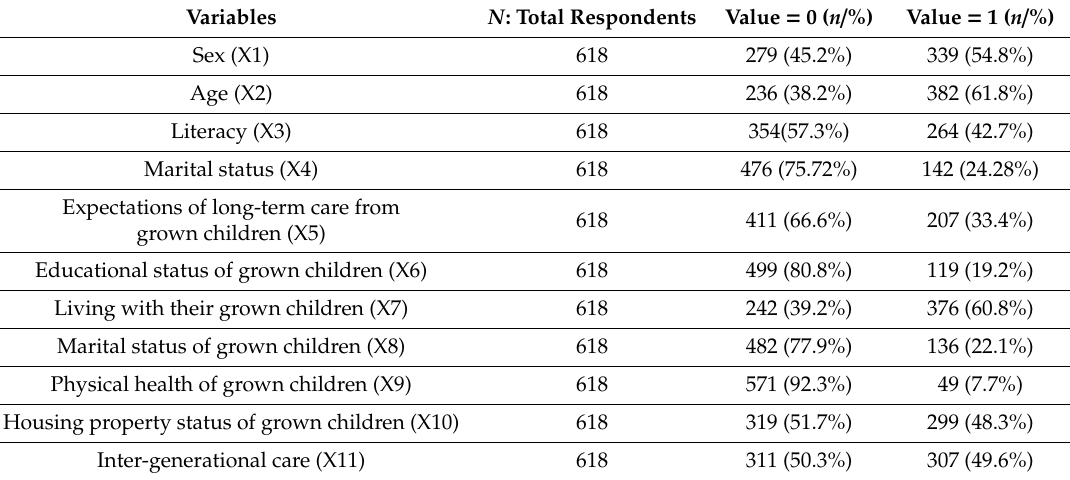
Table 4. Description of the sample.